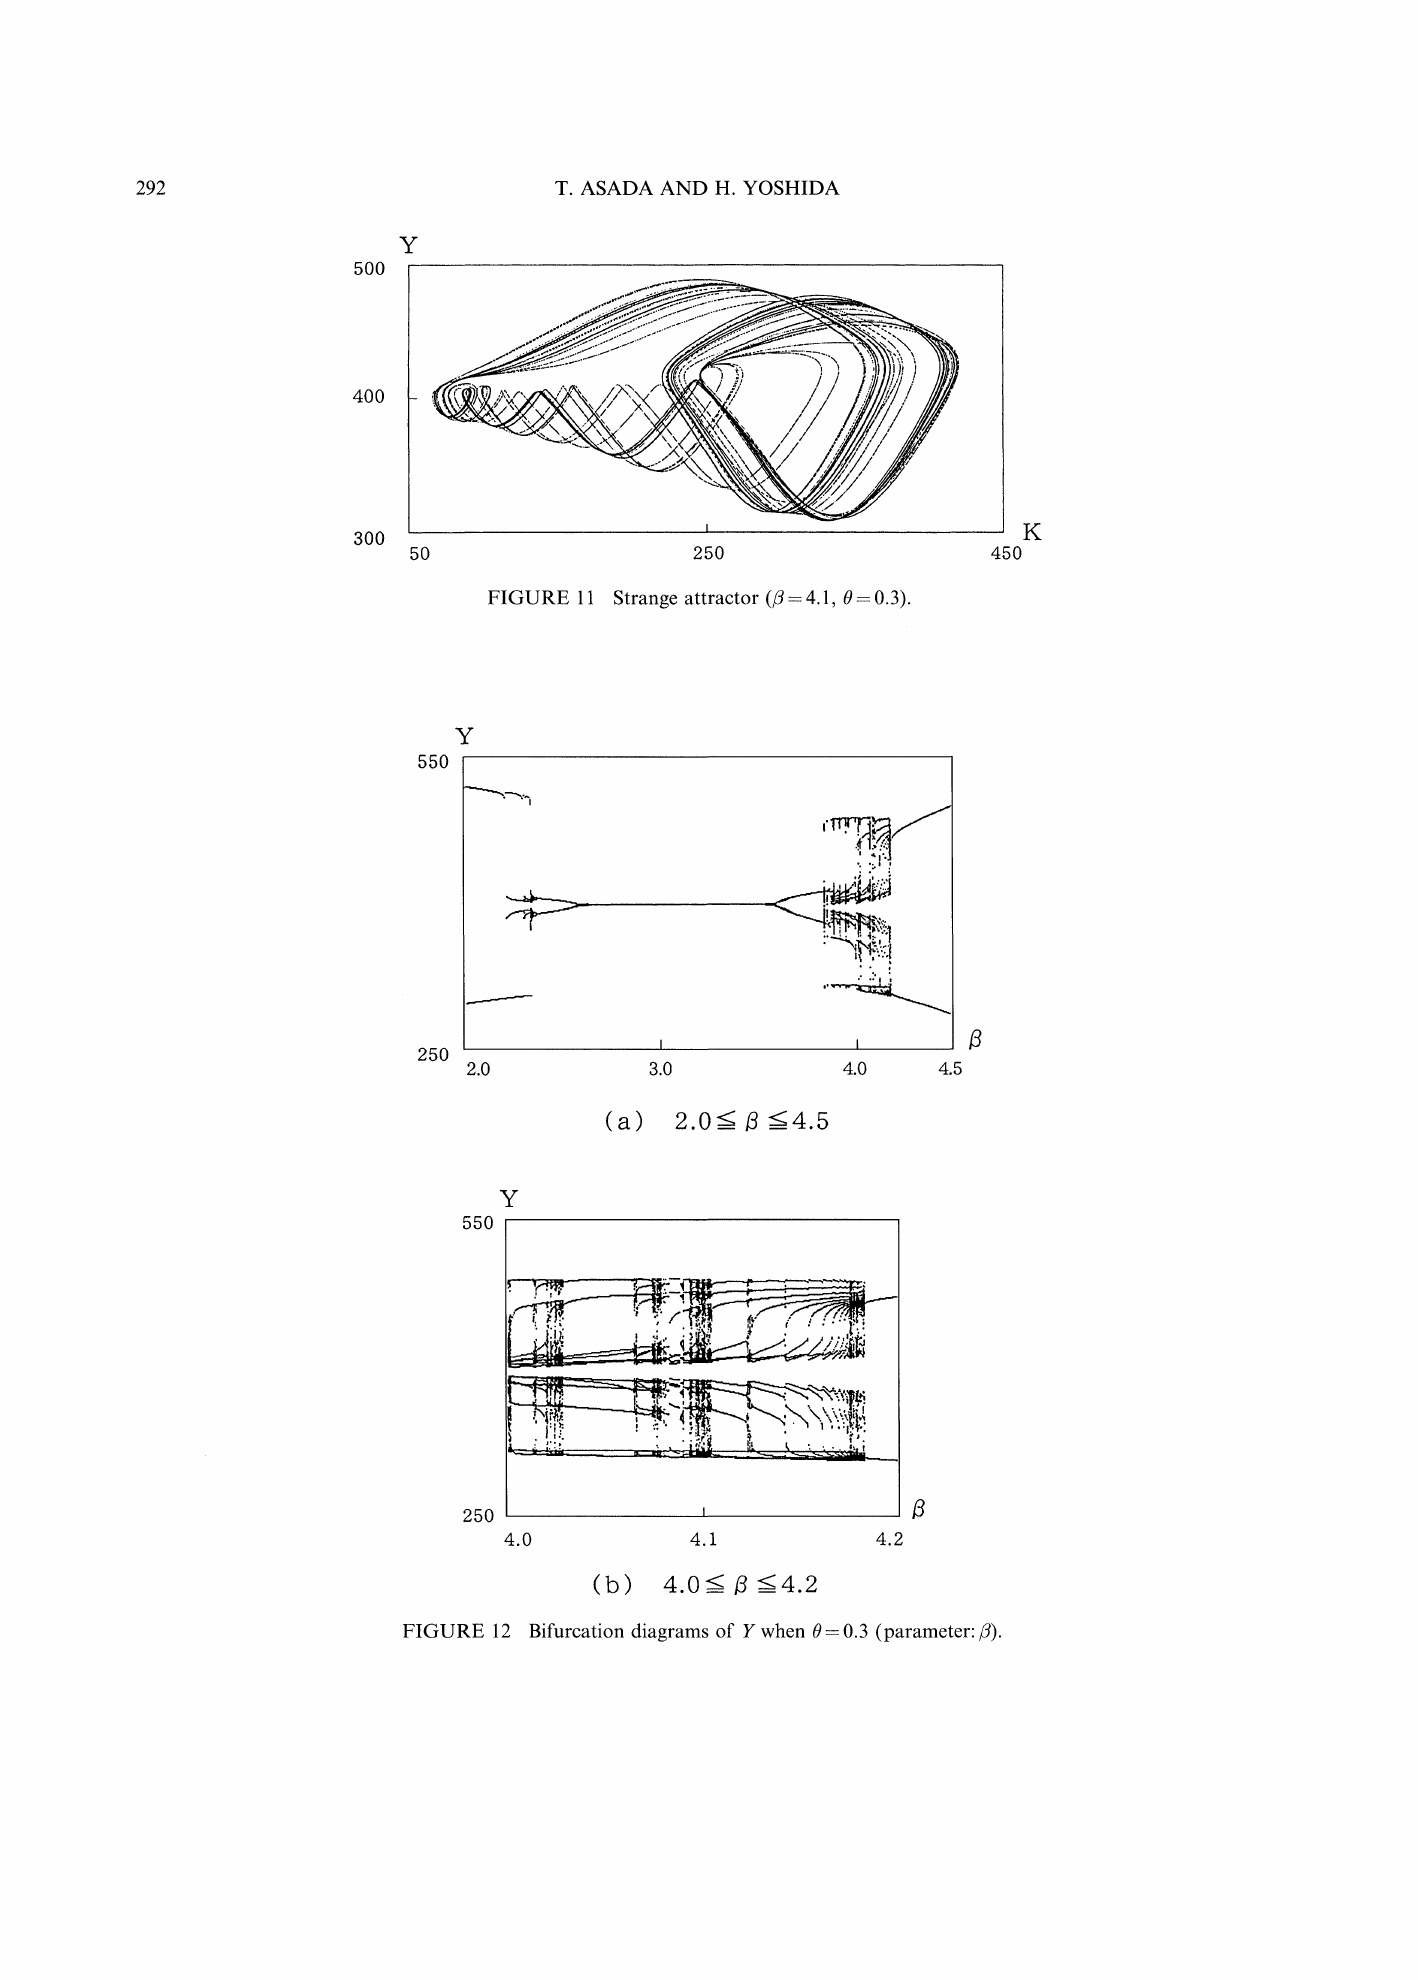
FIGURE 11 Strange attractor (/3=4.1, 0-0.3).